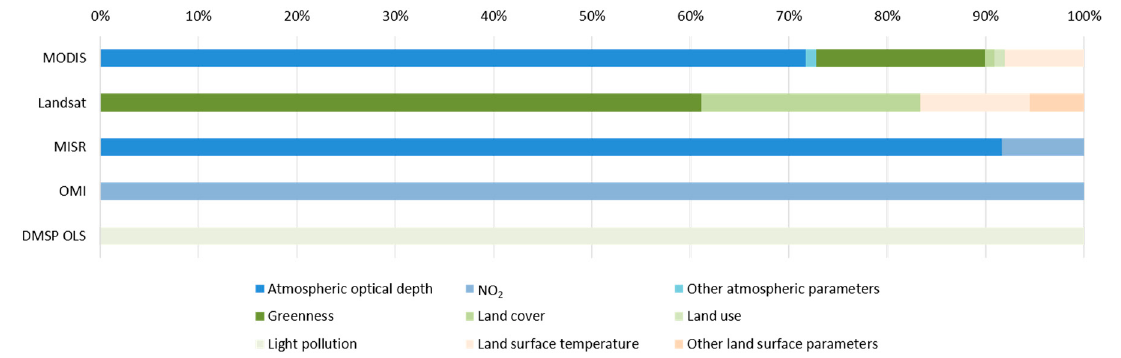
Figure 9. Observed parameters per sensor for the most used sensors.